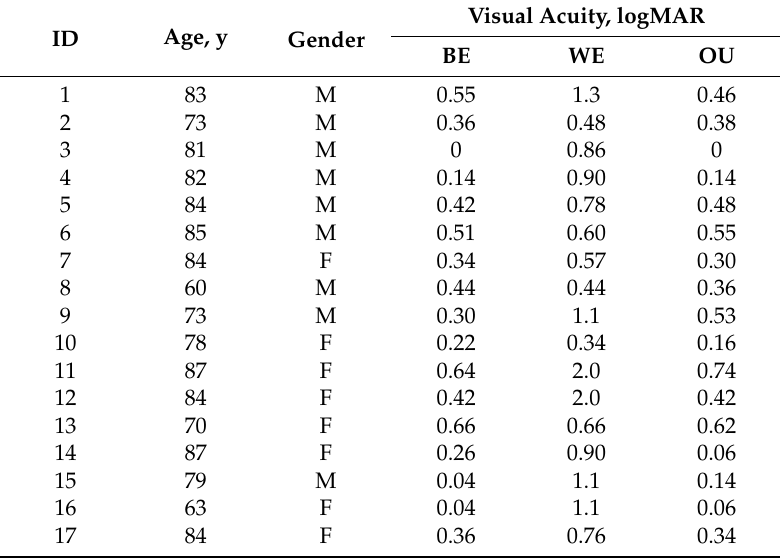
Table 1. Demographic and clinical characteristics of AMD